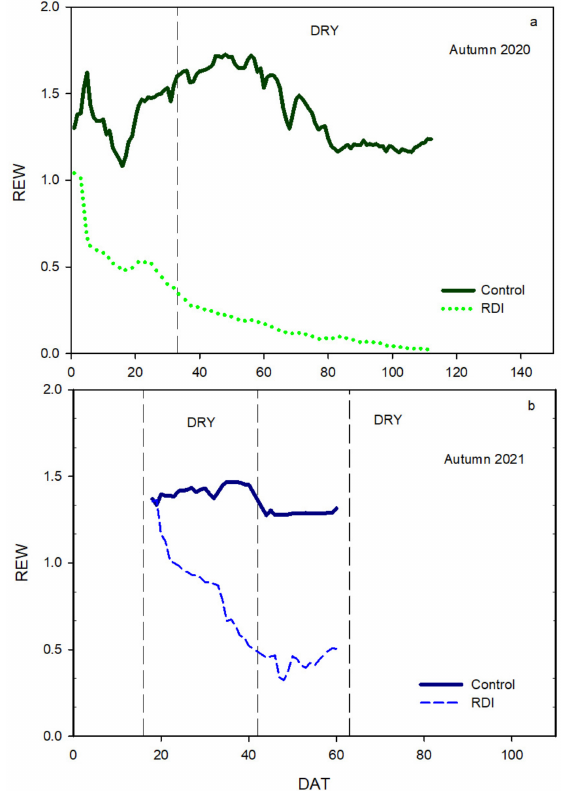
Figure 2. Pattern of soil moisture (REW) at 20 cm depth during the 2020 ( a ) and 2021 ( b ) seasons. Solid lines, Control, Dash lines, RDI. The word “dry” indicates the period without